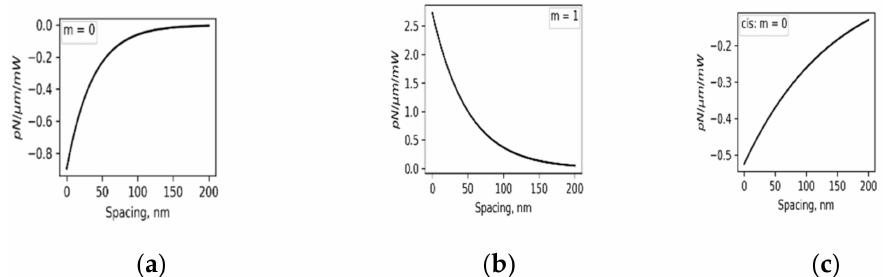
Figure 9. Waveguide pair interaction forces for propagating 340 nm wave. In trans state: ( a ) m = 0, even parity attractive force, and ( b ) m = 2, odd parity repulsive force. In cis state: ( c ) m = 0 supported only. Quality of force is significantly moderated by trans and cis states via changes in refractive indices of